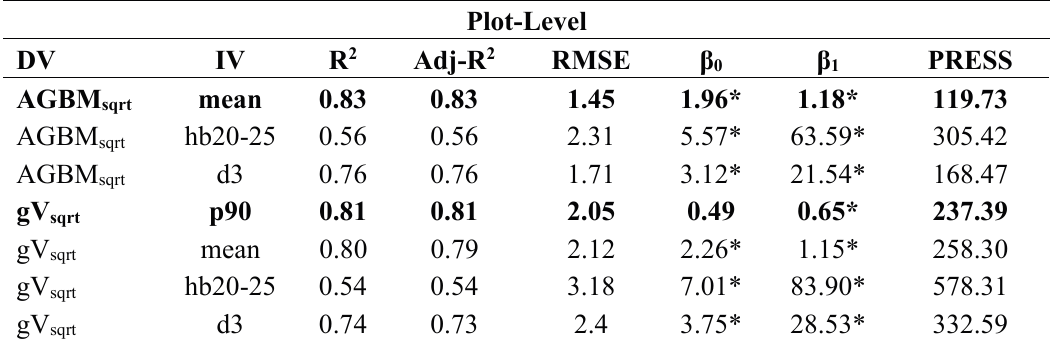
Table 8. Summary of the best clustered subplot-level aboveground biomass and gross volume simple linear regression models for each point cloud metric set. * indicates p-values of less than 0.05.